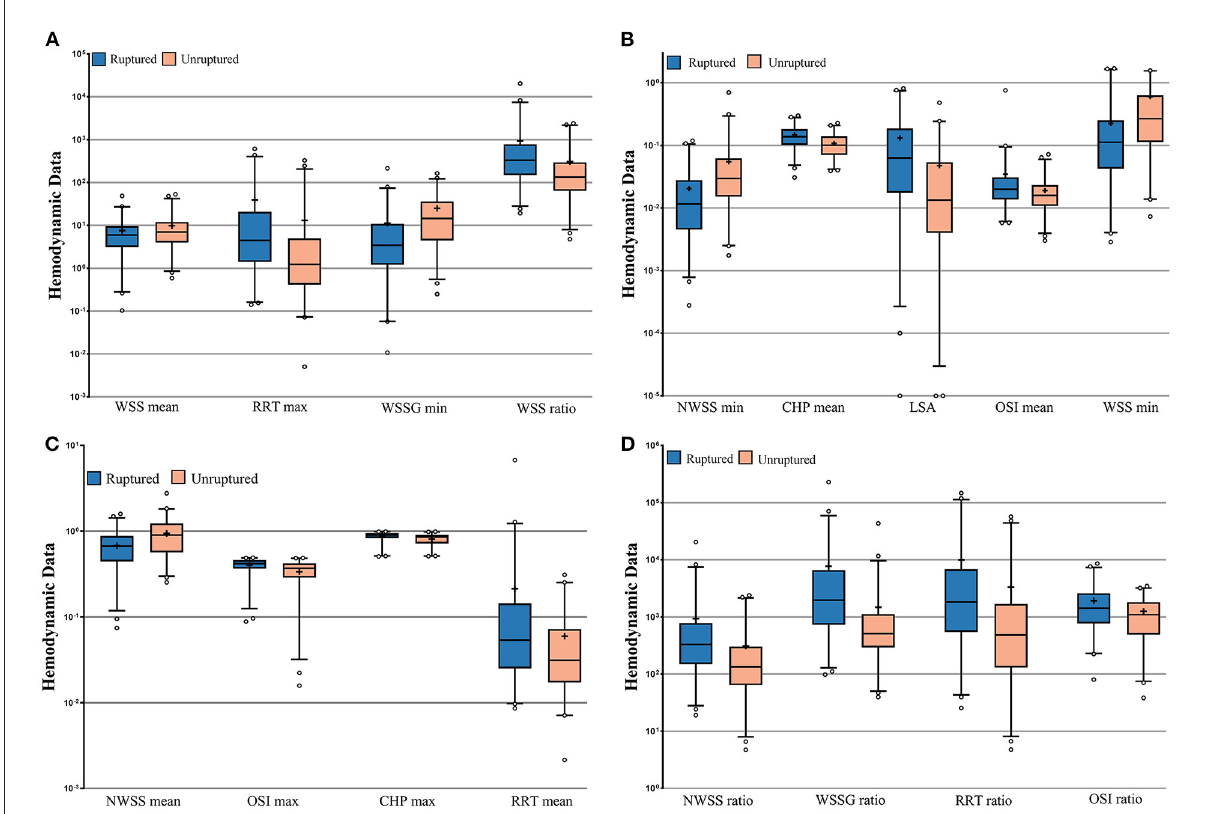
FIGURE3 (A–D) Nested box plots showing the significant variables between the ruptured and unruptured roups. + : mean value; WSS, wall shear stress; NWSS, normalized wall shear stress; WSSG, wall shear stress gradient; OSI, oscillatory shear index; CHP, combined hemodynamic parameters; RRT, relative residence time; LSA, low shear area.